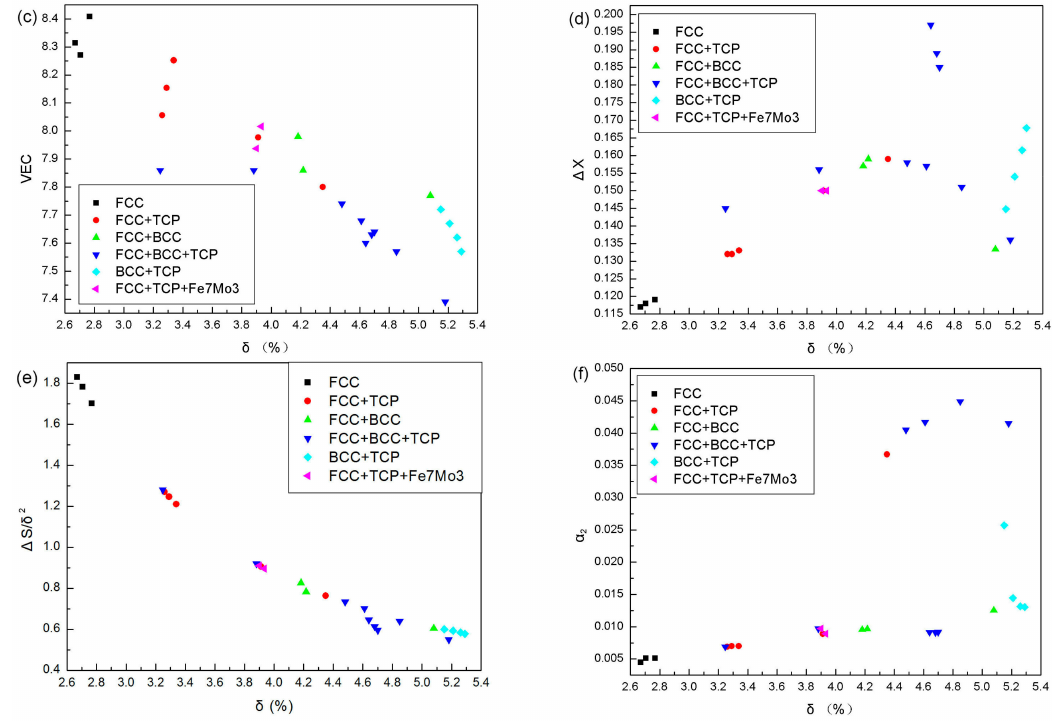
Figure 5. The relationships between parameters and phase